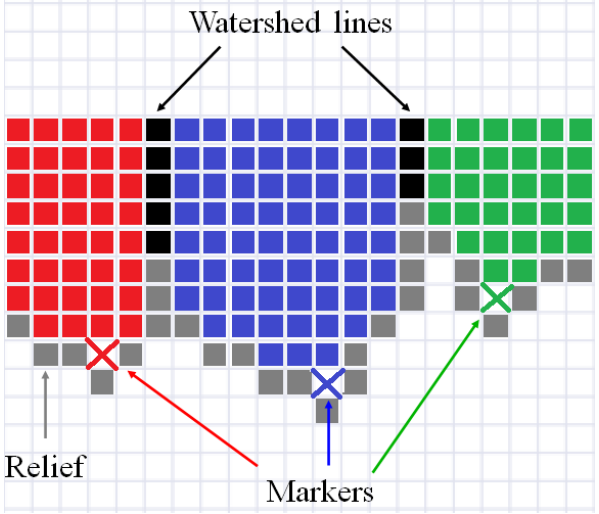
Figure 1. Illustration of marker-controlled watershed for one-dimensional